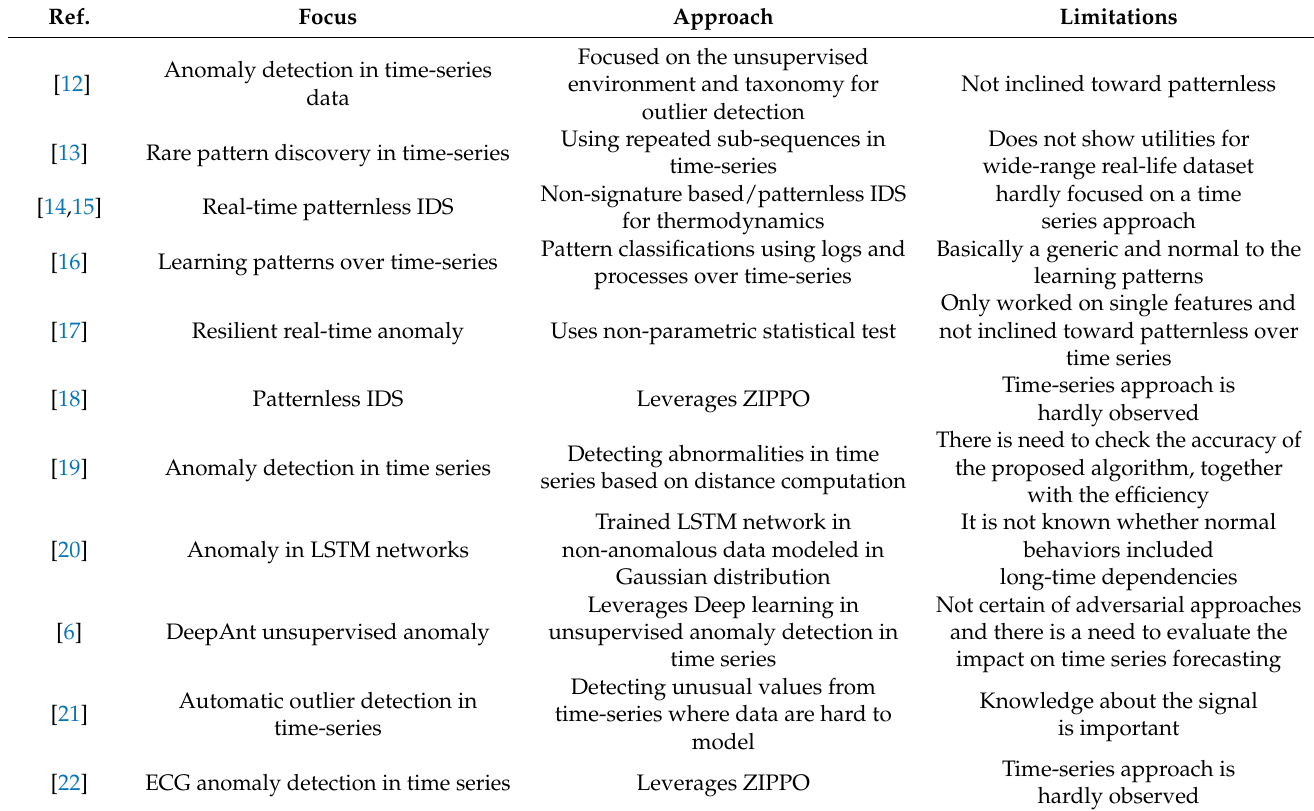
Table 4. Selected relevant studies 1 that comparatively have been mapped to NP-AD in a time series